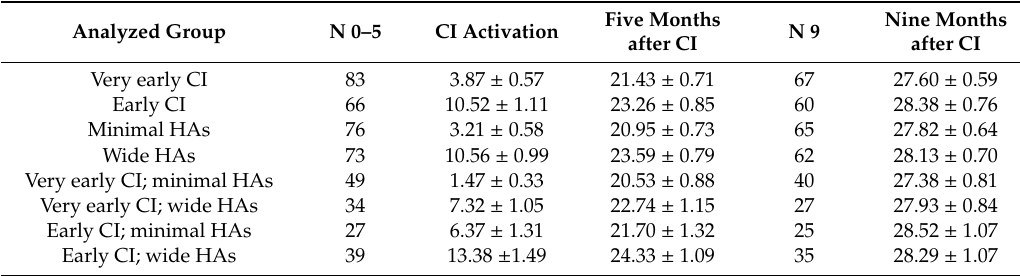
Table 2. LittlEARS questionnaire (LEAQ) scores of the DFNB1 hearing loss (HL) patients in subsequent time